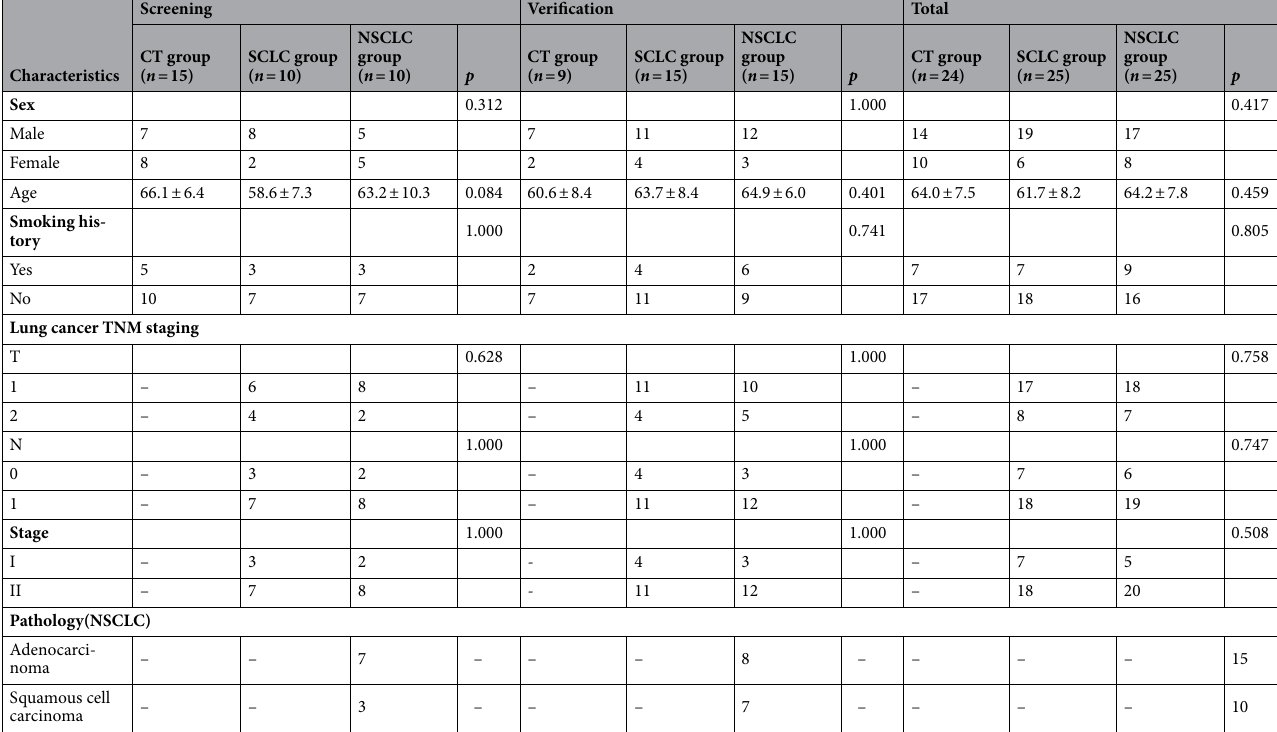
Table 1. Clinical characterization of participants in the CT, SCLC, and NSCLC groups.